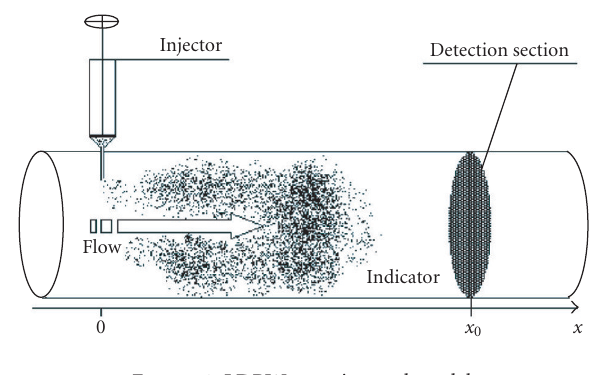
Figure 1: LDRW experimental